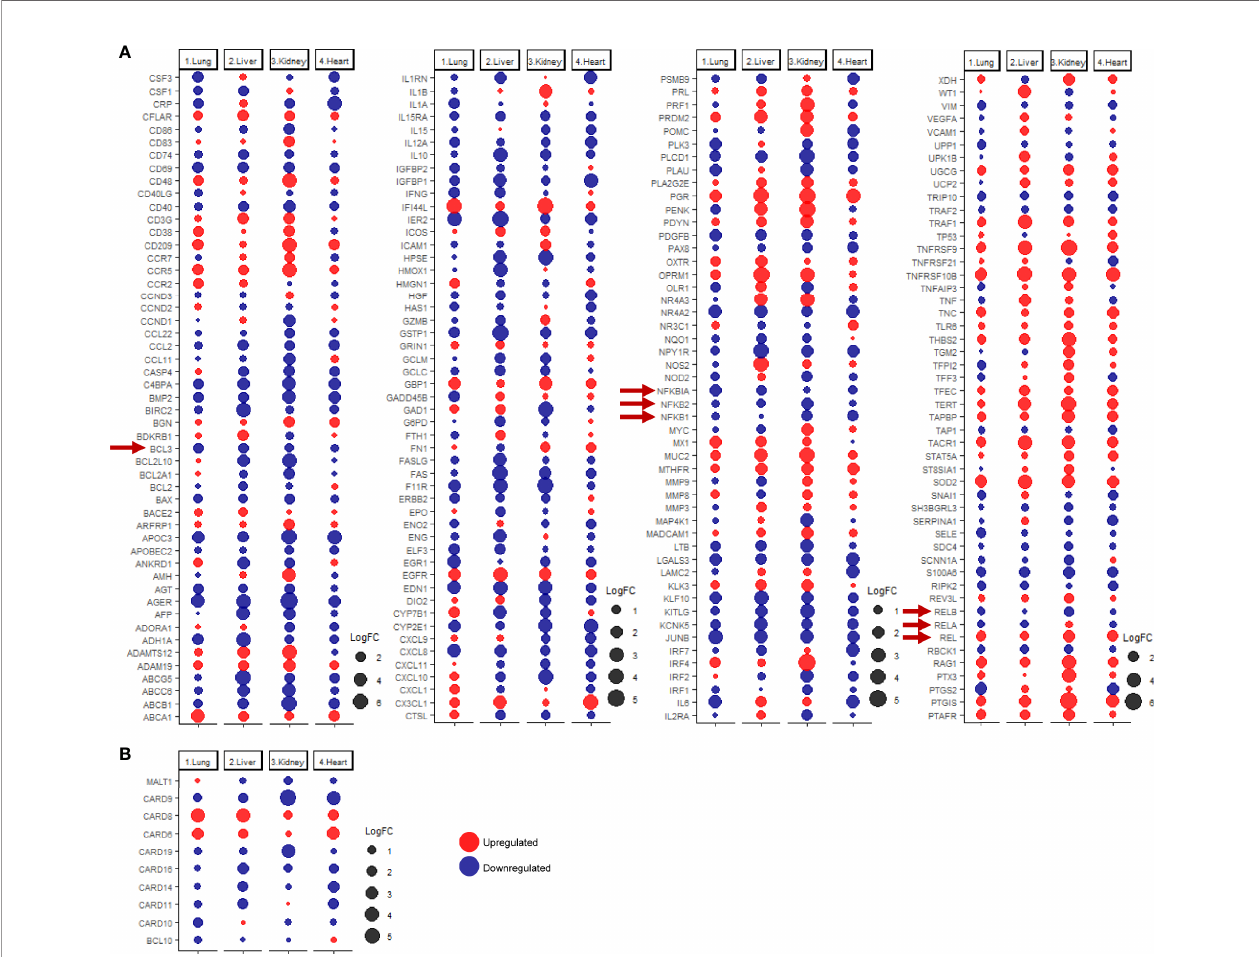
FIGURE 4 | dotplot representation of the expression fold change of (A) inducible NF- k B genes and (B) CBM complex and CARD family proteins in lung, liver, kidney, and heart tissues infected with SARS-CoV-2. Red arrows representing core elements of the NF- k B signaling